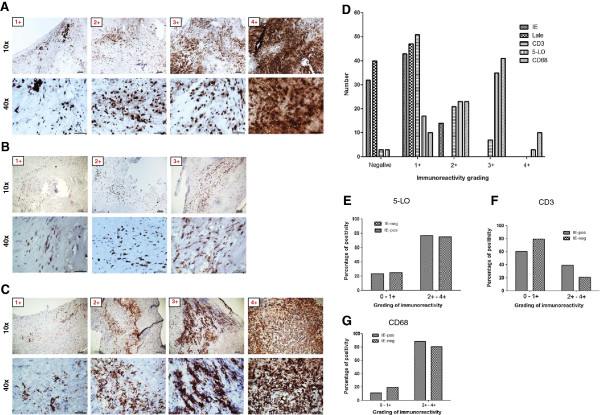
Immunoreactivity and grading of inflammatory markers in association to human cytomegalovirus (HCMV) antigens burden. (A-C) Immunoreactivity and grading of 5-lipoxygenase (5-LO) (A), CD3 (B) and CD68 (C) in plaques. (D) Summary of grading results for HCMV immediate early (IE), late antigen (LA), 5-LO, CD3 and CD68 in plaques. (E-G) Association of HCMV IE antigens with 5-LO (E), CD3 (F) and CD68 (G). Positivity was revealed by diaminobenzidine (DAB), brown products.